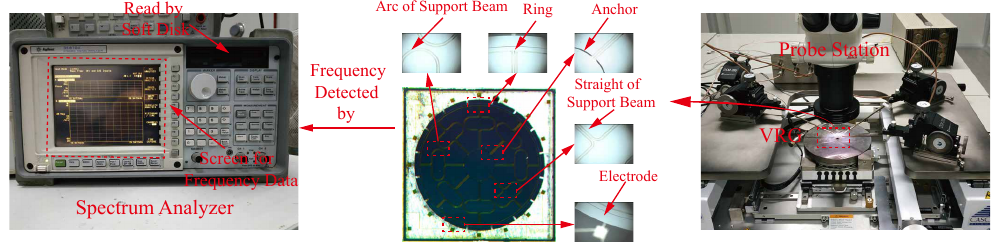
Figure 7. Microscope image of the VRG on the probe station.